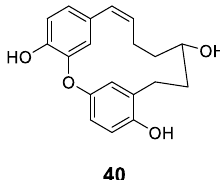
Table 6. Diaryl ether heptenoids, giffonin A–K, Q, R, and S.